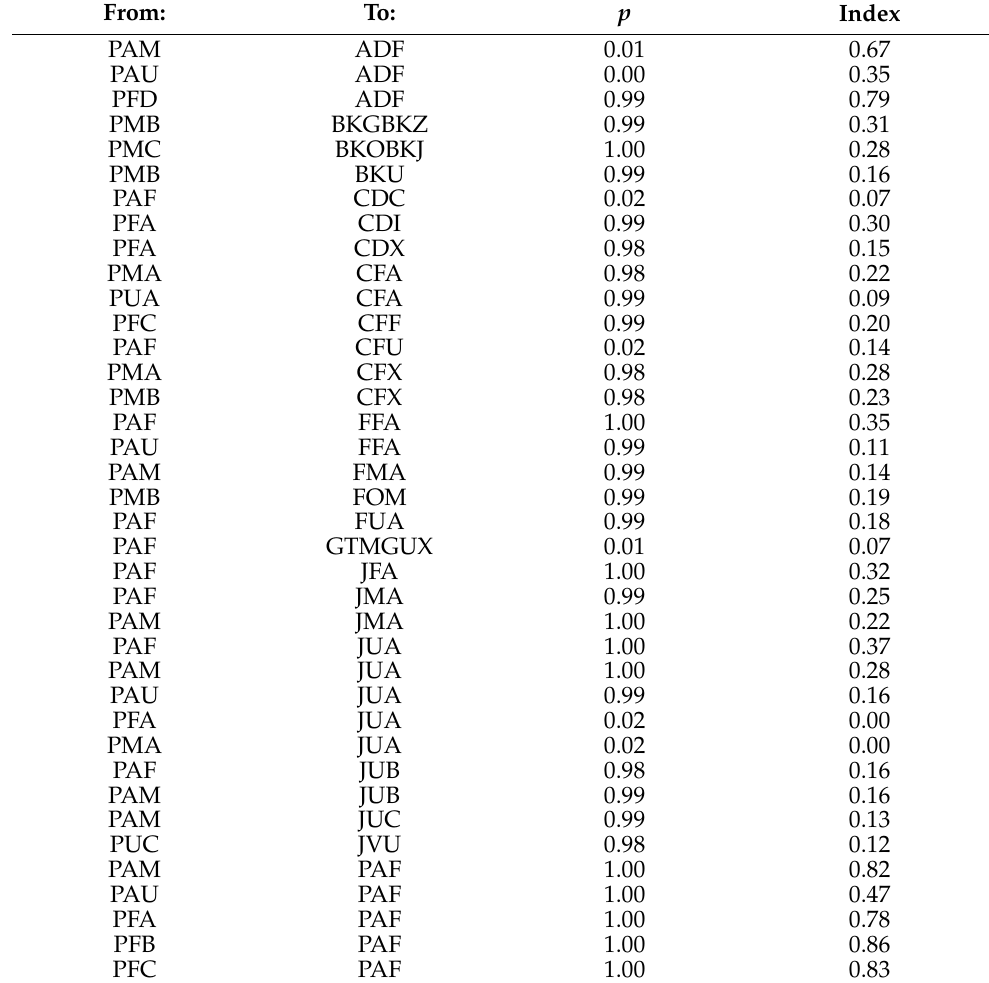
Table A8. Preferred associations from parent-reared chicks to all other flamingos within the network. From: